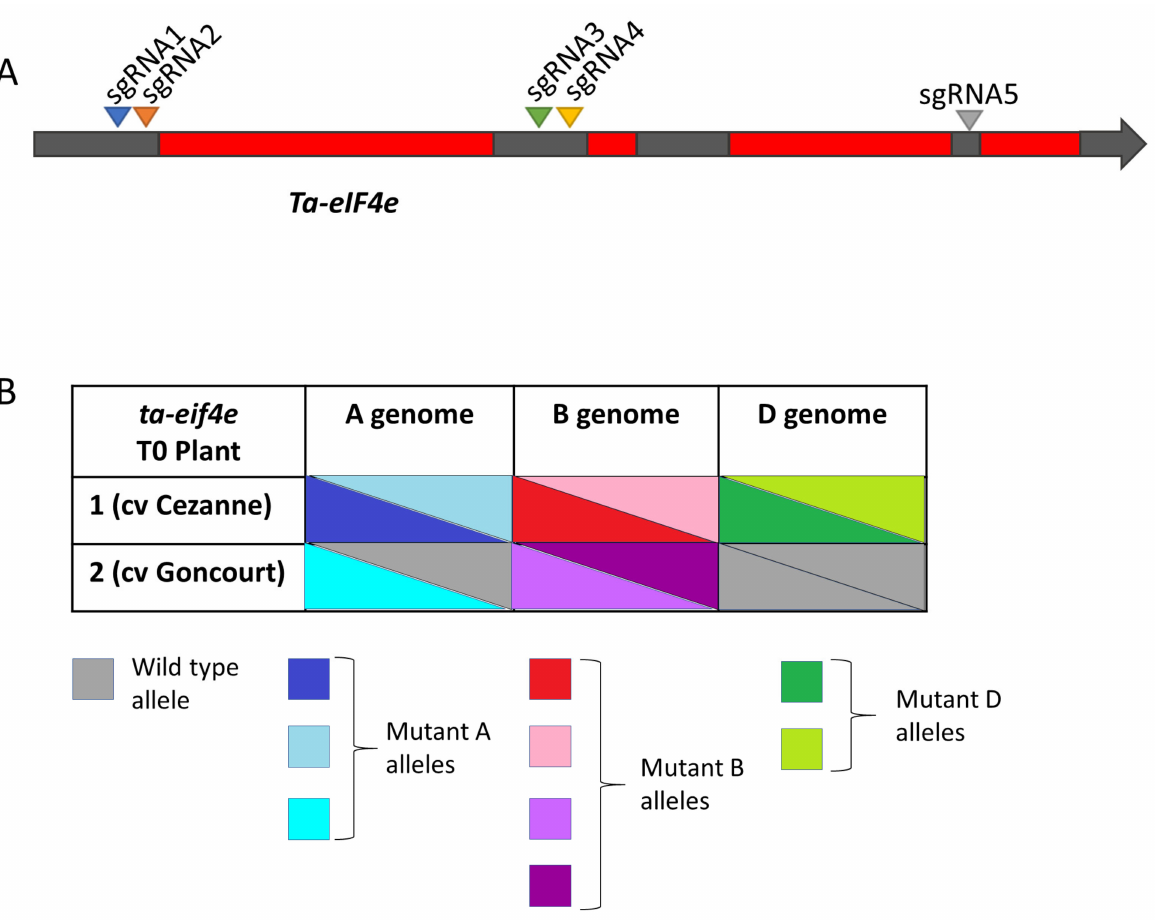
Figure 3. Targeted mutagenesis of Ta-eIF4e . ( A ) Cartoon showing locations of sgRNA target sites and ( B ) allele composition of ta-eif4e T0